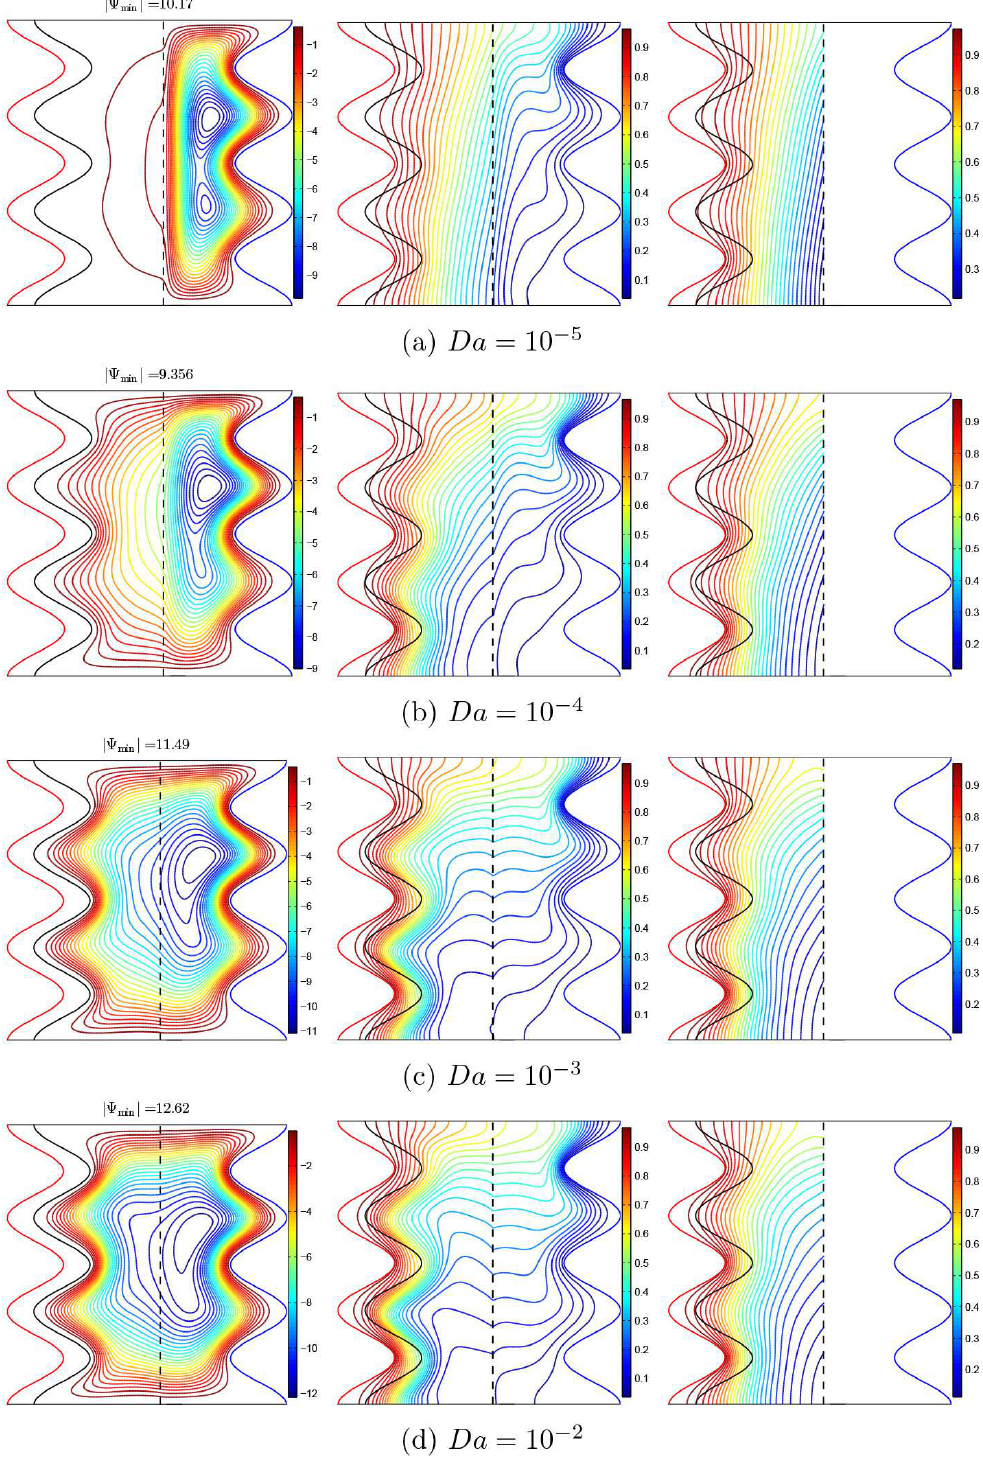
Figure 5. Streamlines ( left ), isotherms of the nanofluid phase ( middle ), and isotherms of the solid phase ( right ) with various Darcy numbers ( Da ); φ = 0.02, γ = 10, A = 0.1, and ε =